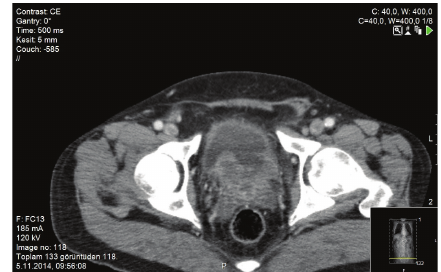
Figure 1: Polypoid mass extending to the lumen of the bladder base.